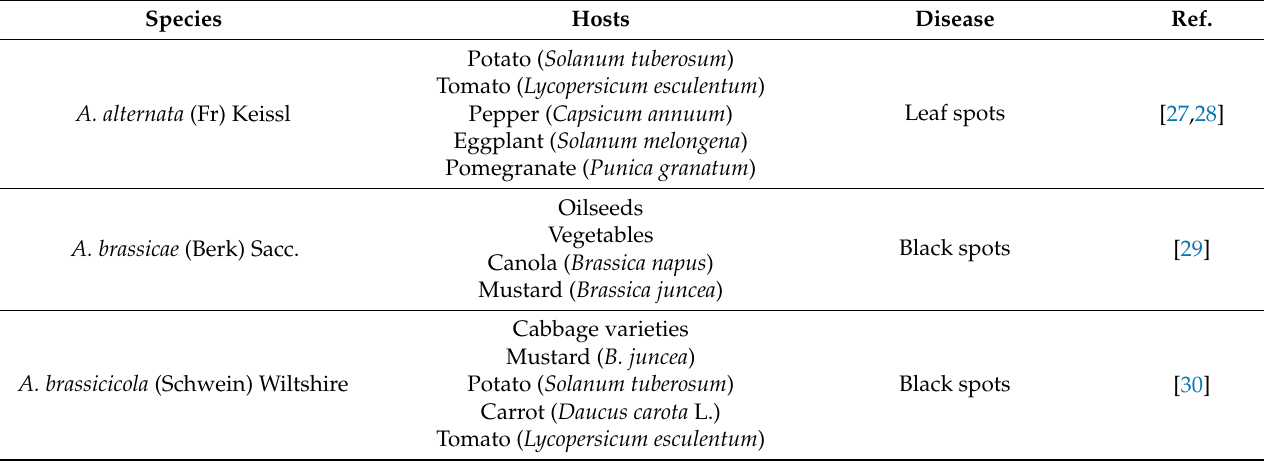
Table 1. Examples of characterization studies in Alternaria species and the different hosts